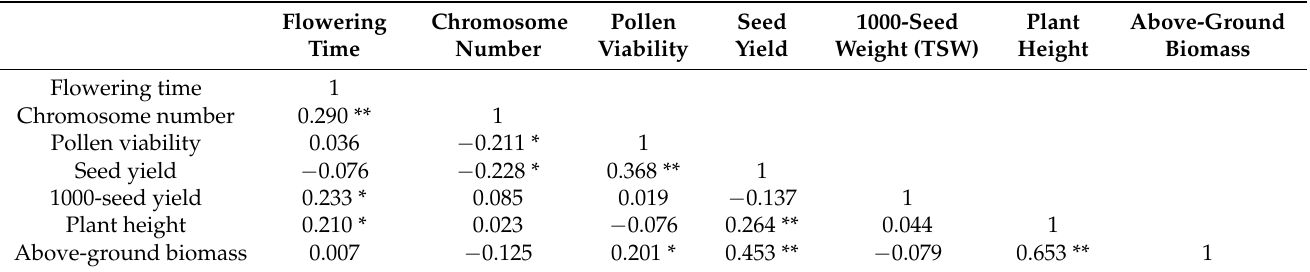
Table 3. The correlation analysis among different traits in S 2 generation derived from an allohexa ‐ ploid Brassica hybrid H16 ‐ 1.